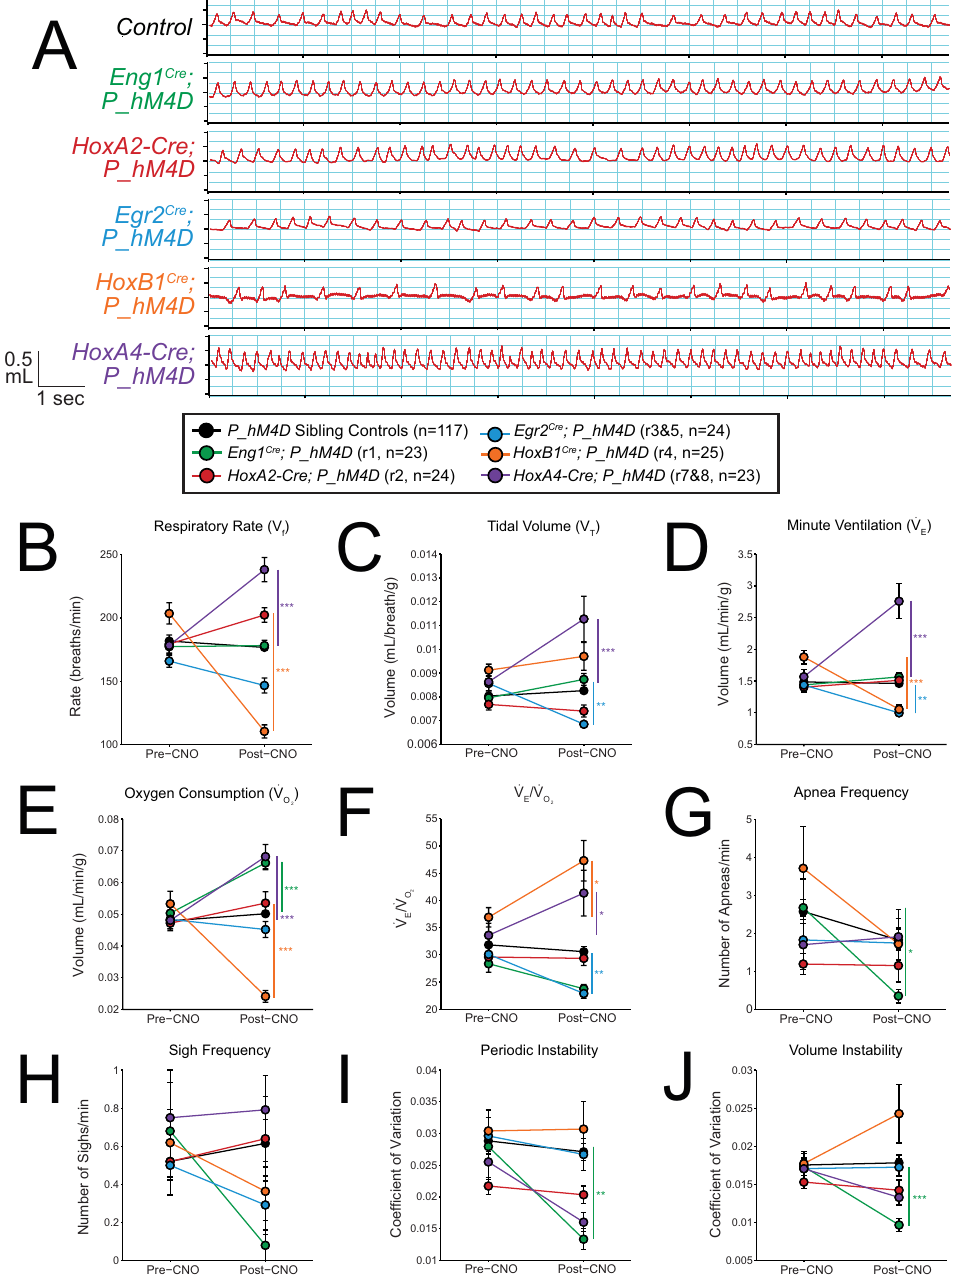
Figure 3. CNO-hM4D perturbation of rhombomeric domains in the adult animal results in a variety of respiratory phenotypes under room air conditions. ( A ) Representative traces of respiratory wavesforms in P_hM4D sibling controls and rhombomere-Cre ; P_hM4D mice after CNO injection under room air conditions. ( B–F ) Quantification of pre- and post-CNO respiratory parameters. Perturbation of rhombomere-derived populations under room air conditions results in increases, decreases, and no change in respiratory rate ( B ), tidal volume ( C ), minute ventilation ( D ), oxygen consumption ( E ),  V /  V ( F ), apnea frequency ( G ), sigh E O 2 frequency ( H ), periodic instability ( I ), and volume instability ( J ) as compared to pre-CNO values and sibling controls. Statistical significance was determined using a linear mixed-effects regression model with animal type (experimental or control) and CNO treatment (pre or post) as fixed effects and animal ID as a random effect. * p < 0.05, ** p < 0.01, *** p <